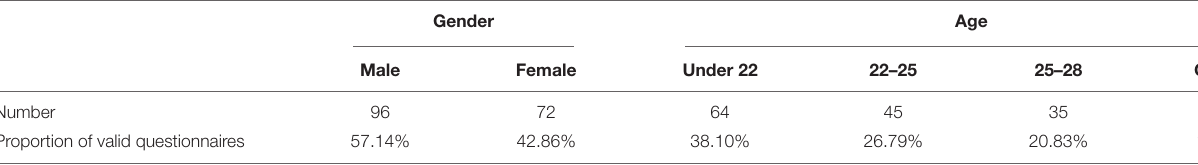
TABLE 6 | Basic information of the respondents.